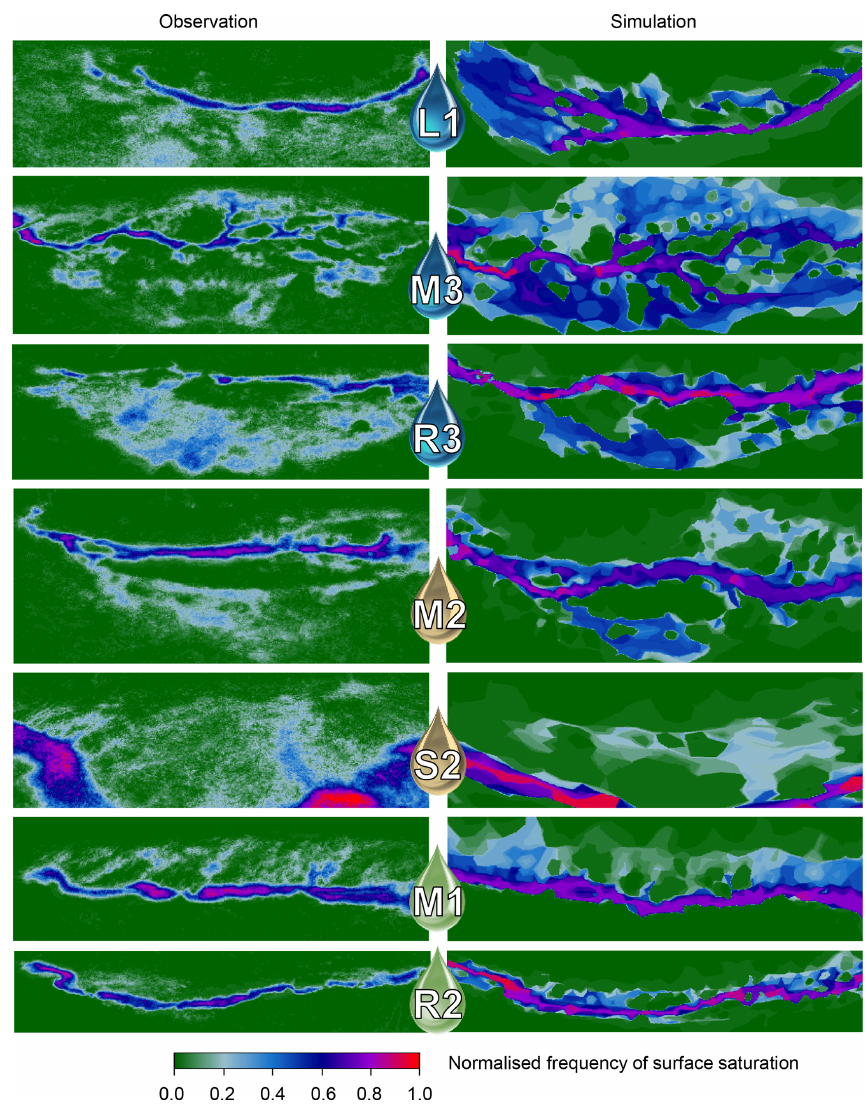
Figure 7. Observed (a) and simulated (b) frequencies of surface saturation in the seven investigated riparian areas along the left (L1), middle (M1–M3), and right (R2, R3) tributary, and the central stream (S2) (cf. Fig. 1). The maps were created by first counting how often the individual pixels were classified as saturated in the individual panoramic images and then normalising the resulting frequency numbers by the total number of images analysed for the respective